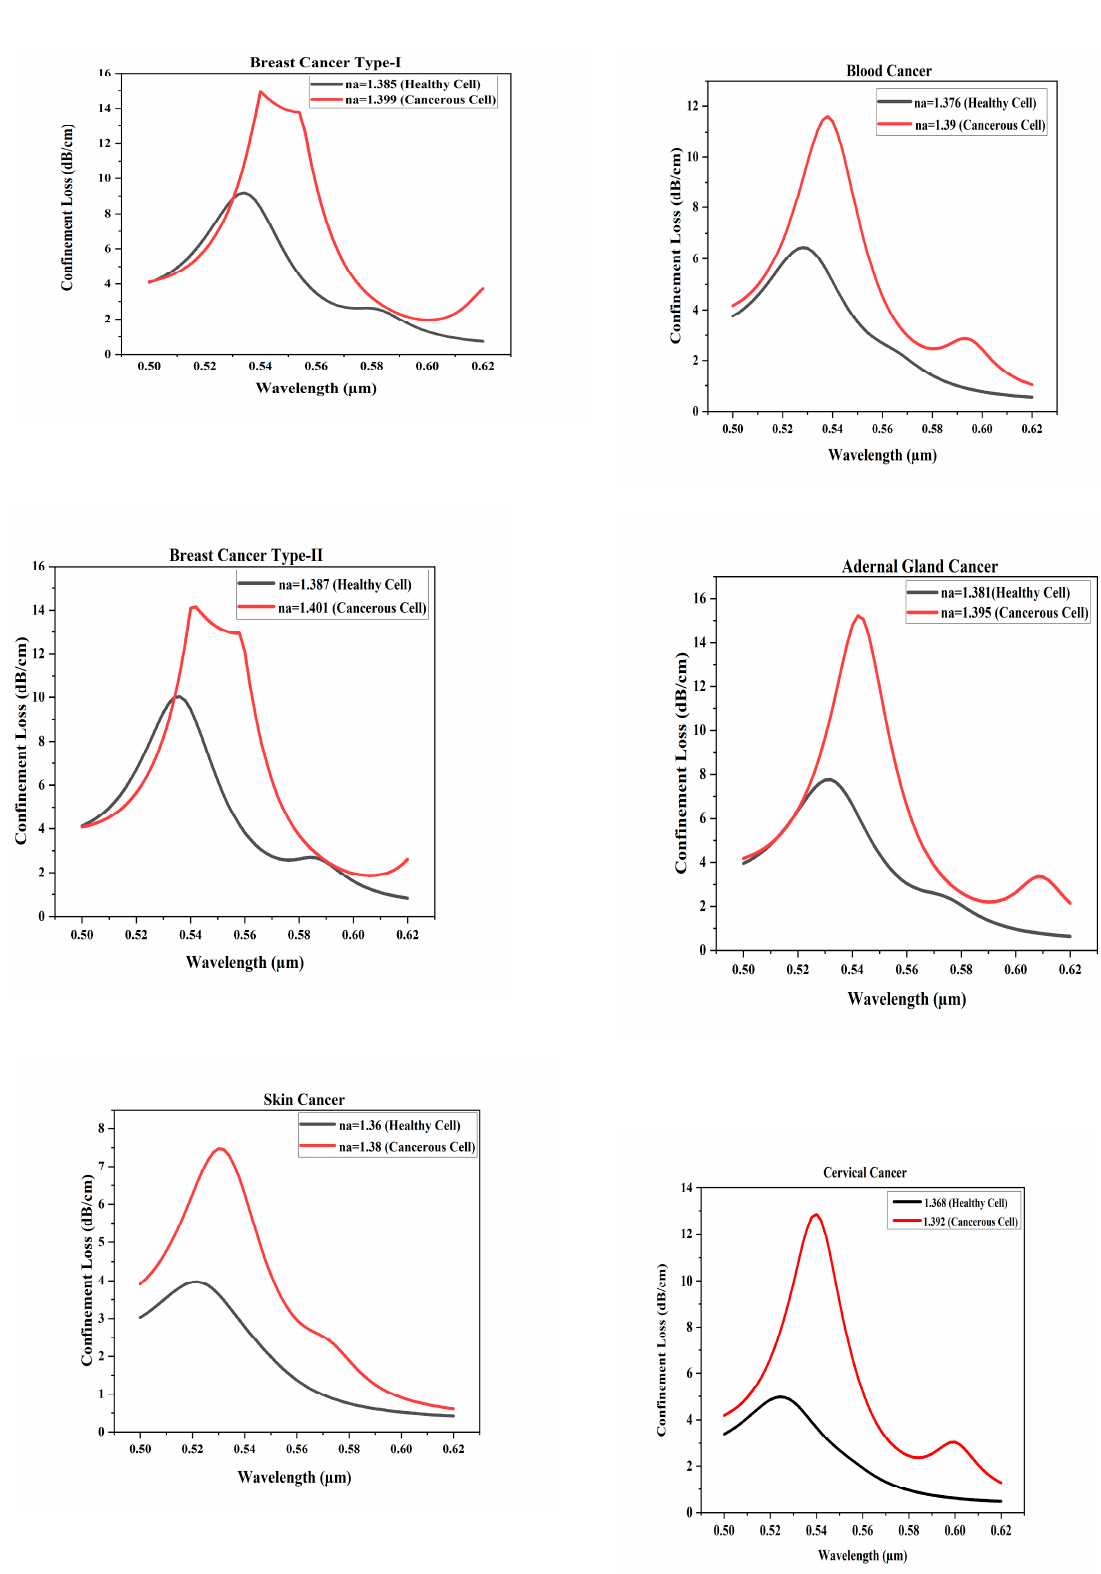
Figure 5. Confinement loss properties of the proposed PCF-SPR biosensor for different kinds of normal and malignant